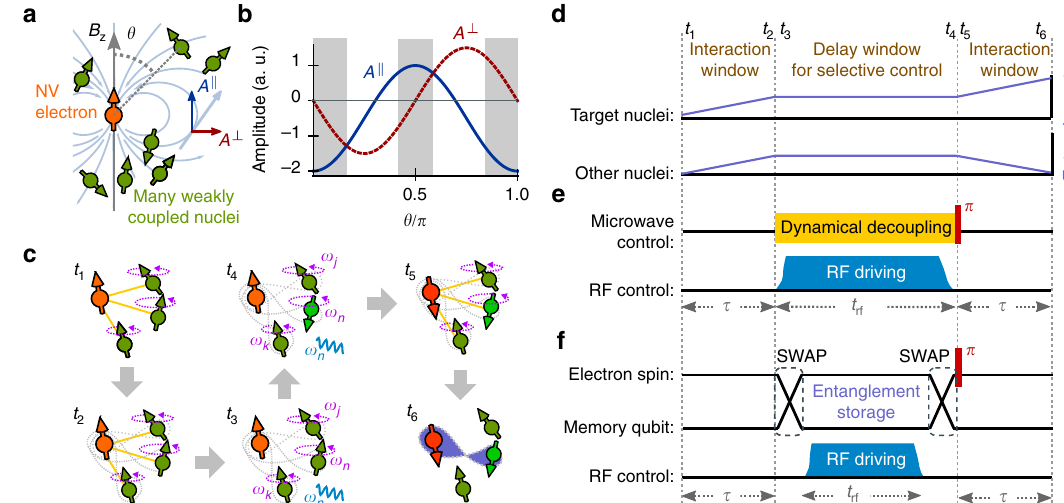
Figure 1 | Delayed entanglement control between the electron and its surrounding nuclear spins. ( a ) A large number of nuclear spins weakly coupled to the electron spin of NVcentre by the hyperfine field. ( b ) Relative amplitudes of the components of the hyperfine field. The perpendicular component A ? is weaker than the parallel component A || at the shaded regions of the plot. ( c ) Illustration of the spin states in the process of delayed entanglement echo, with the entanglement changes sketched in d . Implementation of the delay window by DD ( e ) or by storing the entanglement to a long-lived memory qubit ( f ). During the delay window, the driving at RF frequencies provides highly selective control on nuclear spins for addressing. A p pulse applied at the end of the delay window eliminates the coupling from unwanted nuclei as well as static